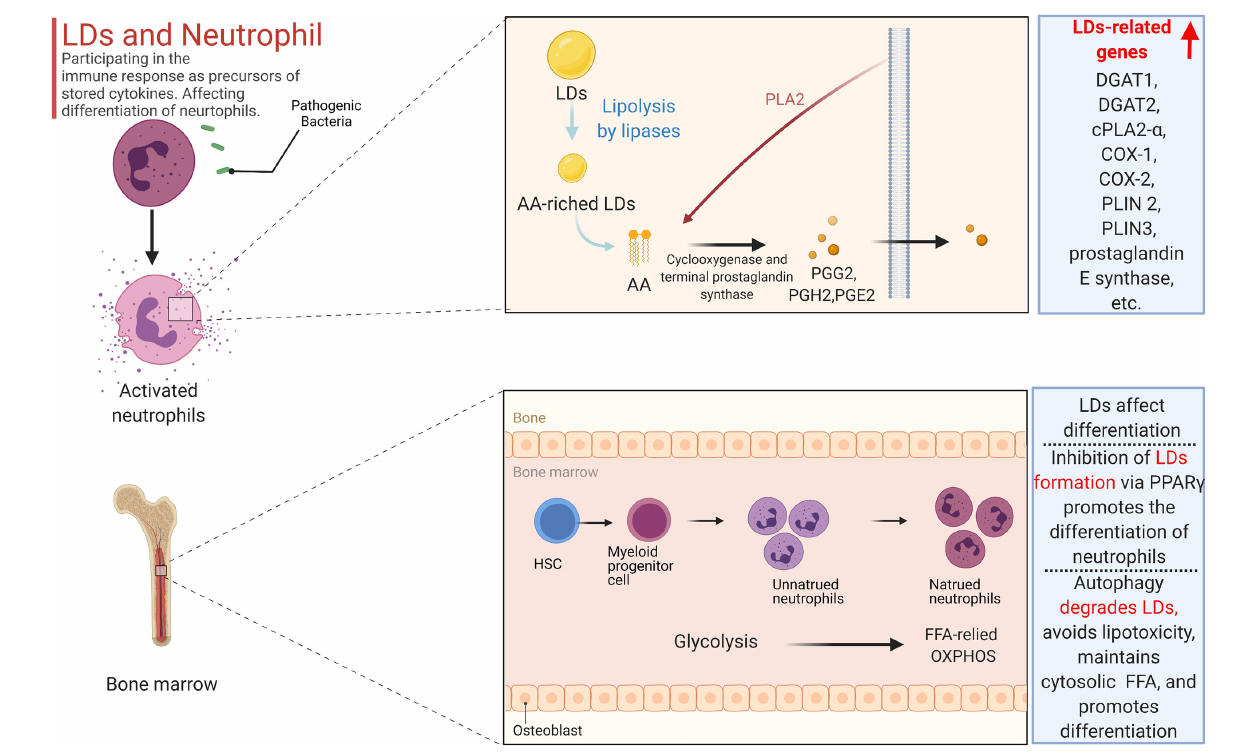
FIGURE 2 | The formation of LDs is not only related to lipogenesis but also closely related to fat degradation, all of which not only affects neutrophil differentiation but also participates in the immune response as precursors of stored cytokines (primarily arachidonic acid) in the neutrophil. Free AA can be obtained by enzymatic decomposition of membrane phospholipids or can be released from AA-rich triglycerides stored in LD in some cells. Phospholipids can be cleaved by phosphorylated cytoplasmic PLA 2 to produce free fatty acids including AA, which in turn forms prostaglandins G2 (PGG 2), PGH 2, and PGE2, catalyzed by cyclooxygenase (COX-1 and COX-2) and terminal prostaglandin synthase. In the activation of neutrophils induced by Cr-LAAO, the microarray data also proved that the expression of lipid-related genes was up-regulated. Inhibition of galectin-12 in ATATA-induced human promyelocytic leukemia cell NB4 inhibits lipid droplet formation via PPAR γ , and ultimately promotes the differentiation of neutrophils. Autophagy can degrade LD, not only preventing lipid accumulation and avoiding lipotoxicity, but also releasing free fatty acids to maintain the total amount of cytosolic fatty